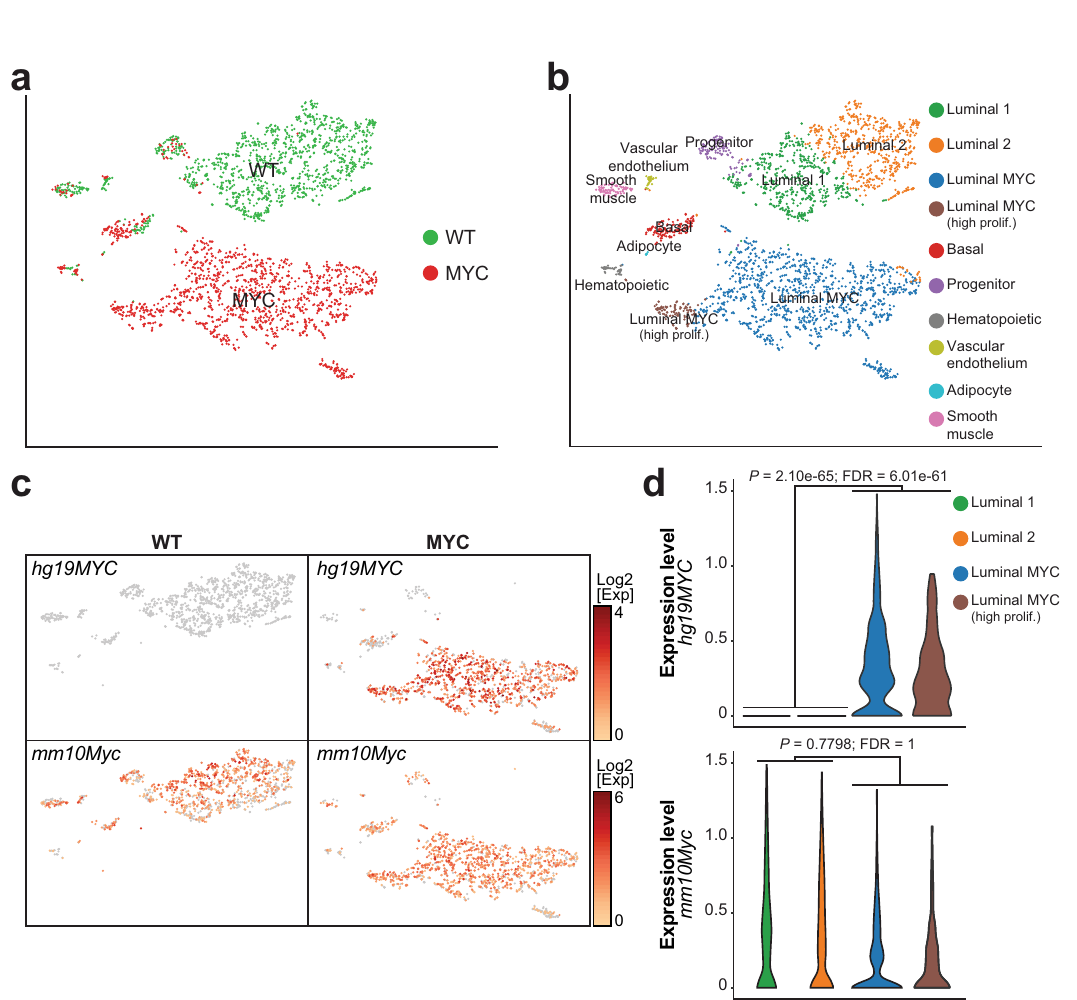
Fig. 2 Single-cell transcriptome reveals distinct luminal cell subpopulations. a, b Single cell census of the WT and MYC-transformed VP ( a ) followed by unsupervised clustering revealed four luminal subsets ( b VP; n = 1 per genotype). c , d Human MYC transcript ( hg19MYC ) is only observed in MYC- transformed VP and mostly restricted to the luminal subsets while murine Myc transcript ( mm10Myc ) is expressed across cellular populations and genotypes ( c VP; n = 1 per genotype) and is not correlated with hg19MYC expression in luminal cells ( d VP; n = 1 per genotype; edgeR: two-sided quasi- likelihood